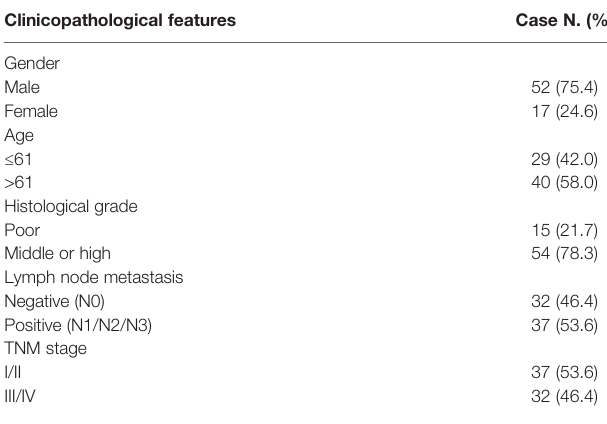
TABLE 1 | Clinicopathological data of esophageal squamous cell carcinoma. Clinicopathological